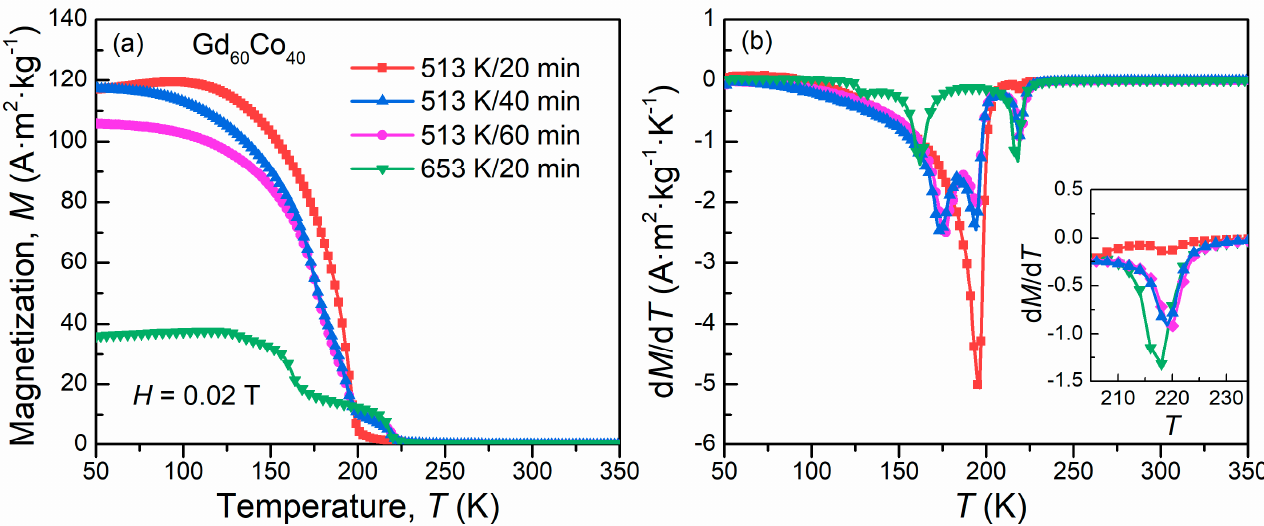
Figure 2. ( a ) Temperature dependence of magnetization and ( b ) d M /d T - T curves of the Gd 60 Co 40 alloys after annealing treatment. The inset of ( b ) is the magnified image of the part between 210 K and 230 K.